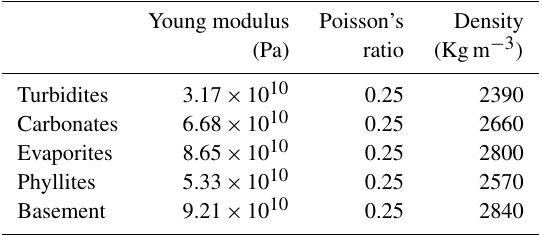
Table 1. Adopted parameters for the various rock formations (Pauselli and Federico, 2003; Mirabella et al.,